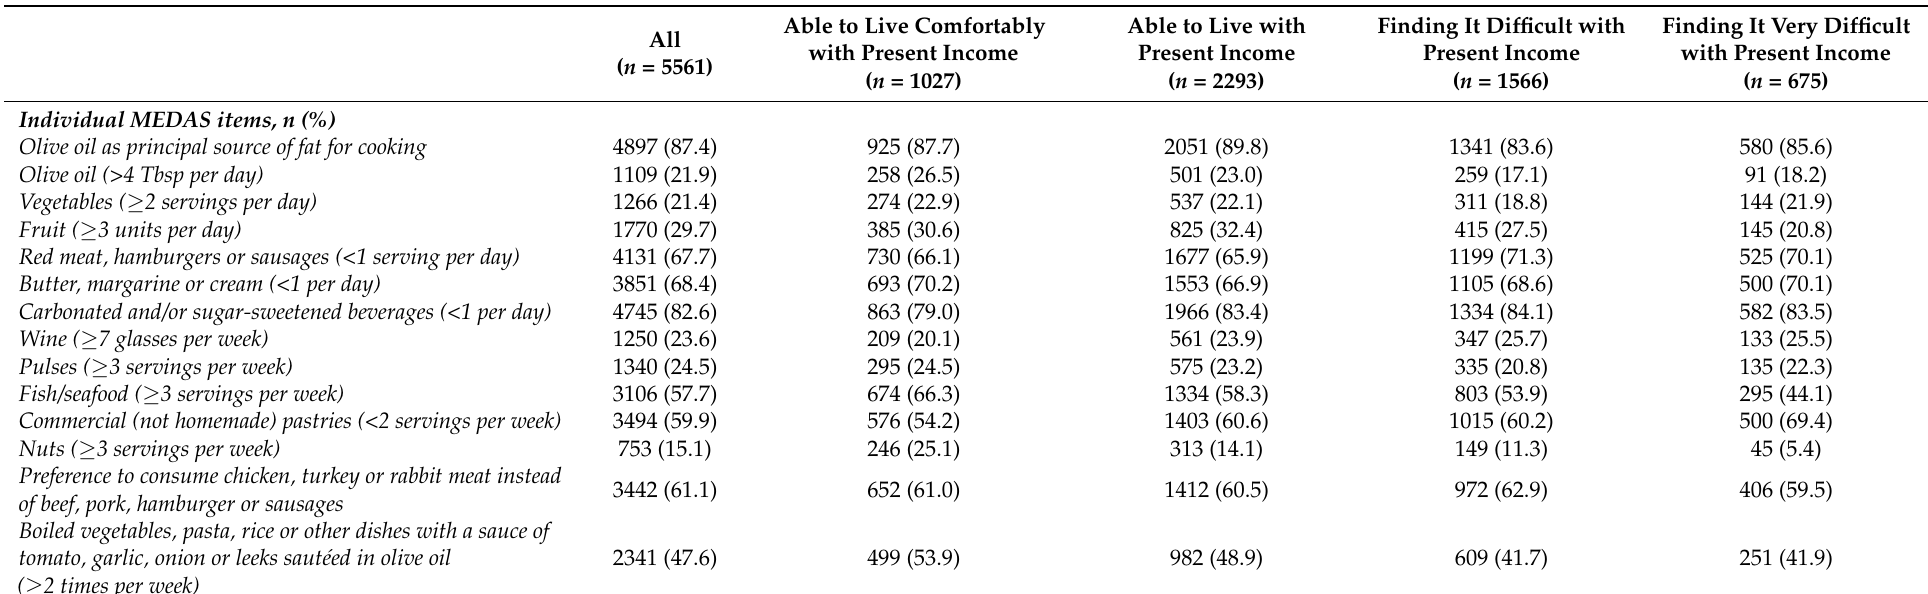
Table 2. Individual MEDAS items according to four income perception